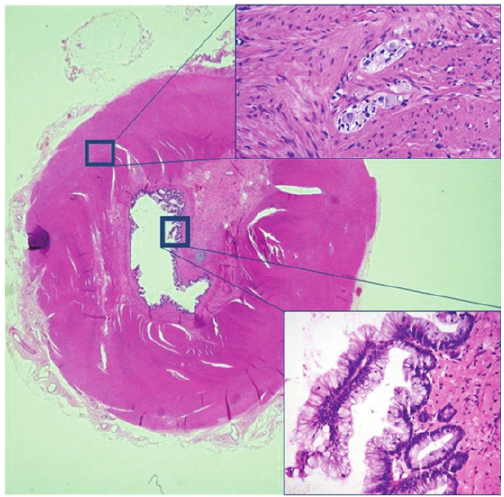
Figure 2: Intestinal duplication. The cyst wall clearly shows the concentric layering of a normal bowel wall. The tunica muscularis consists of two discrete smooth muscle layers with an intervening myenteric nerve plexus (upper inset). A submucosa and mucosa are also recognized. The mucosa displays a diffuse low-grade villous adenoma (lower